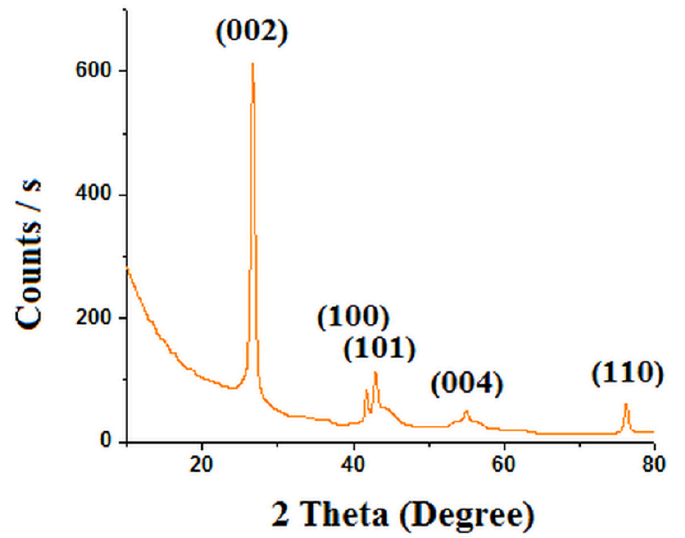
planes present in the current 10 BNNF sample are (002).